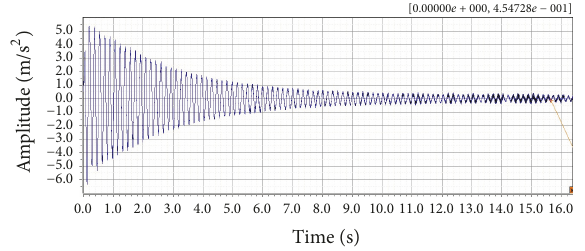
Figure 23: Response of the flexible arm under the larger frequency